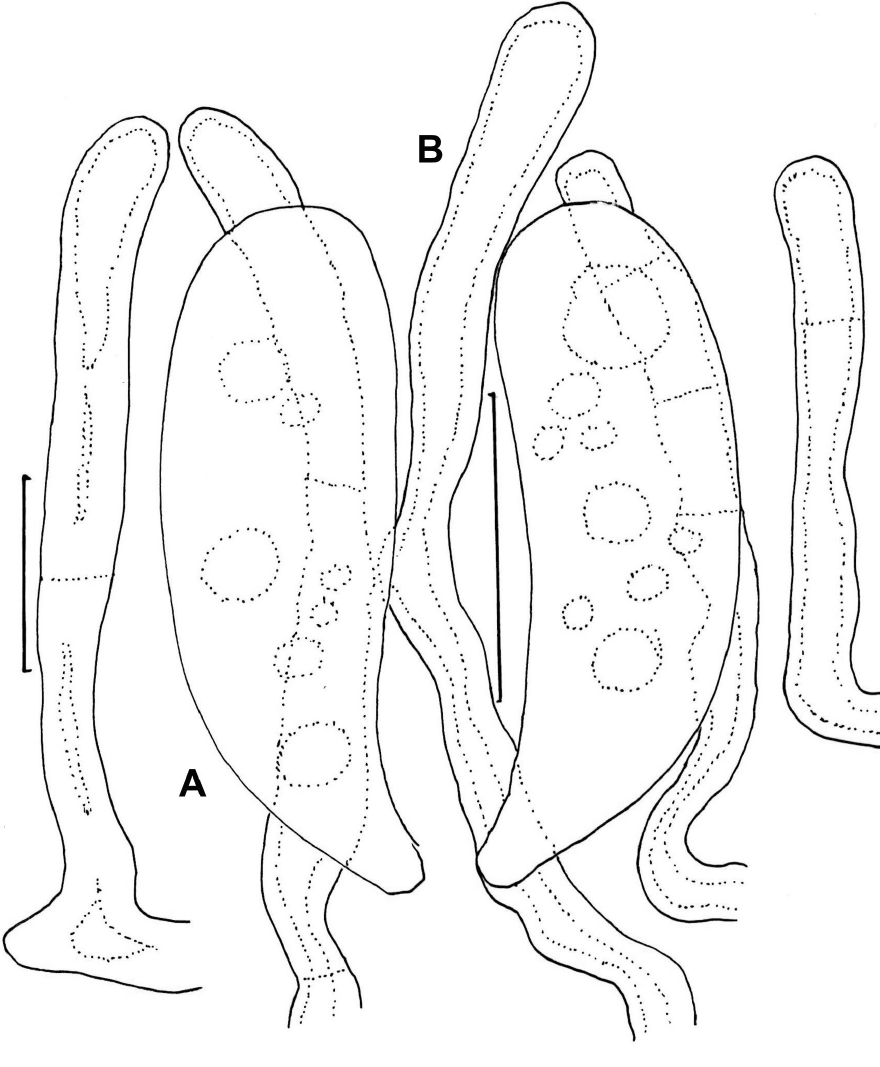
Figure 49. Mycetinis olidus . Caulocystidia and basidiospores. A Basidiospores (DED 4529) B Caulocys- tidia (VA 97 257). Standard bars: A = 5 µm; B = 20 µm. VA 97 257 (TENN